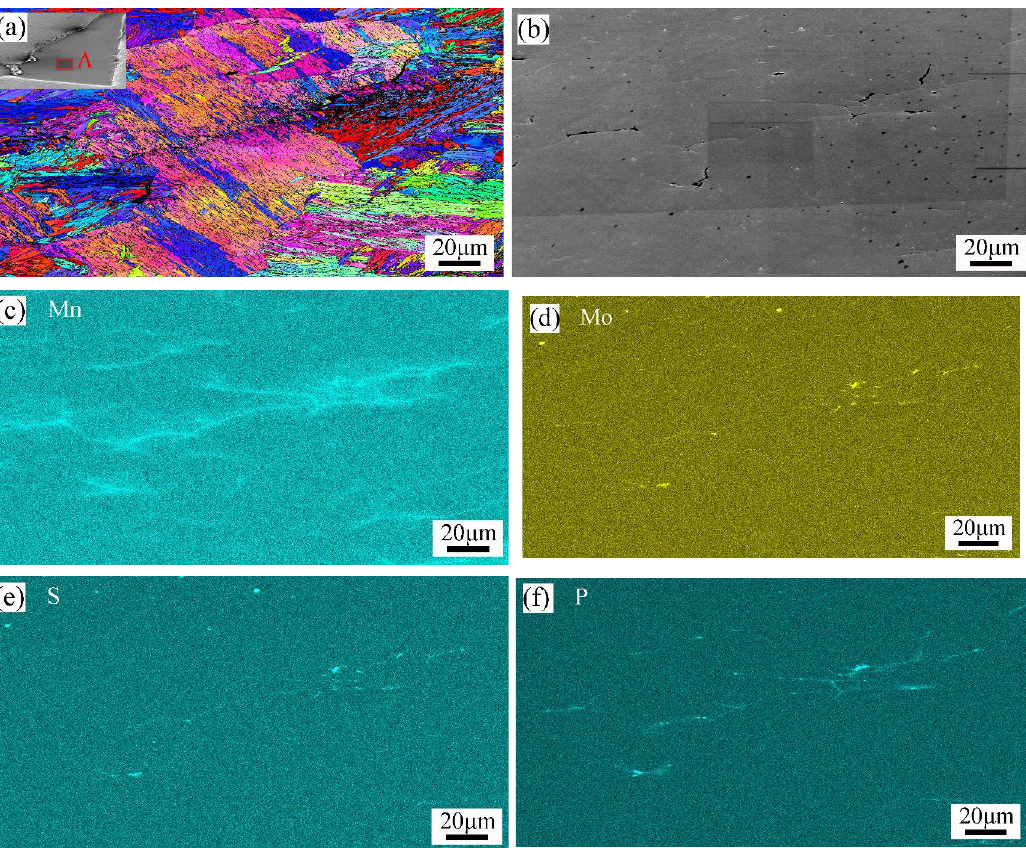
Figure 18. Microstructure and chemical composition distribution of location A: ( a ) IPF X; ( b ) SEM picture; ( c ) Mn; ( d ) Mo; ( e ) S; ( f ) P.